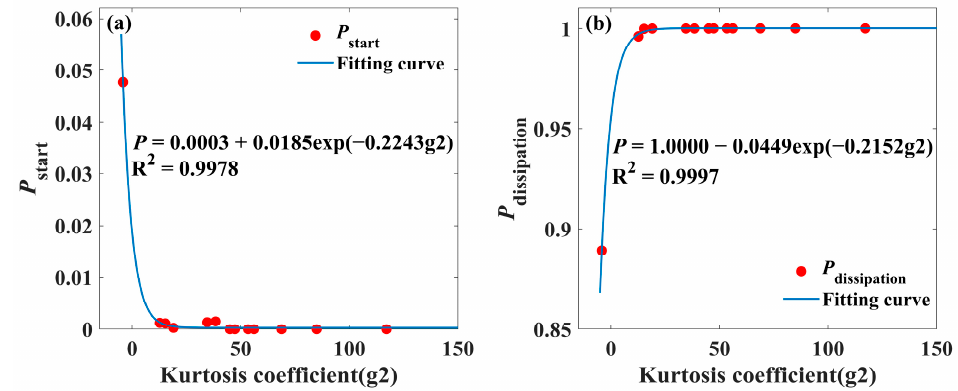
Figure 12. Curvilinear relationships between the start and dissipation percentiles and the kurtosis coe ffi cients (( a ) is curvilinear relationships between the start percentiles and the kurtosis coe ffi cients and ( b ) is curvilinear relationships between the dissipation percentiles and the kurtosis coe ffi cients).